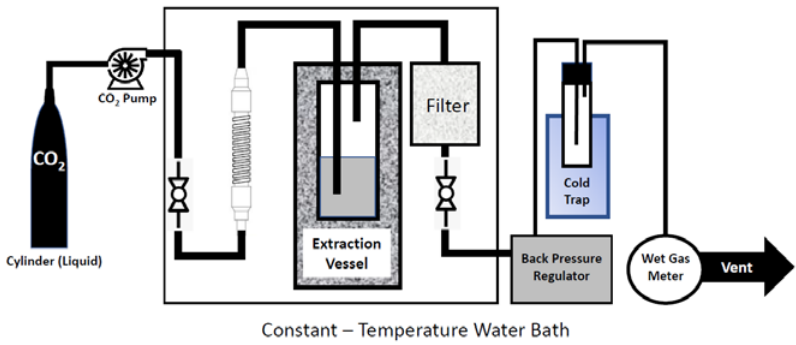
Figure 3. Schematic diagram of subcritical water extraction (SWE).